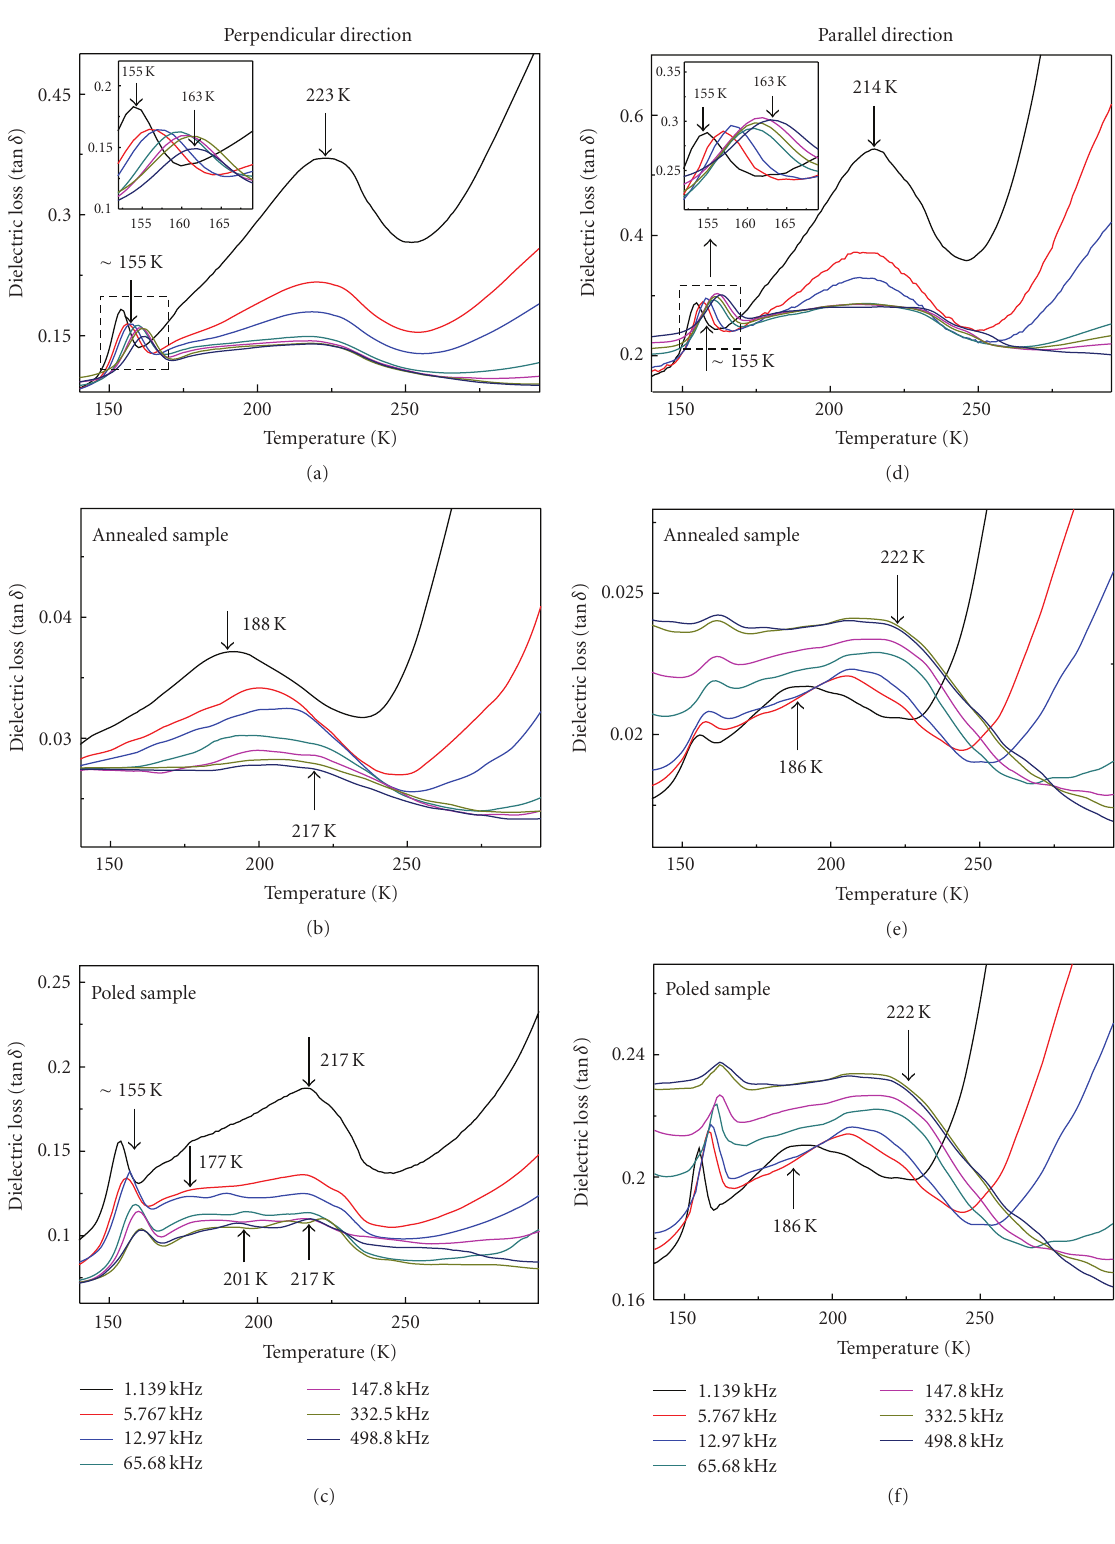
Figure 5: Dielectric Loss versus temperature for di ff erent frequencies: (a) perpendicular direction, inset: the enlarged ∼ 155 K peak, (b) perpendicular direction by annealed, (c) perpendicular direction by poled, (d) parallel direction, inset: the enlarged ∼ 155 K peak, (e) parallel direction by annealed, and (f) parallel direction by